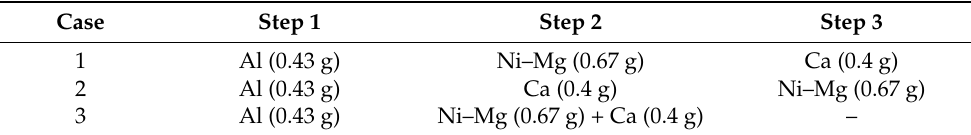
Table 2. Addition sequence of deoxidizer and alloy